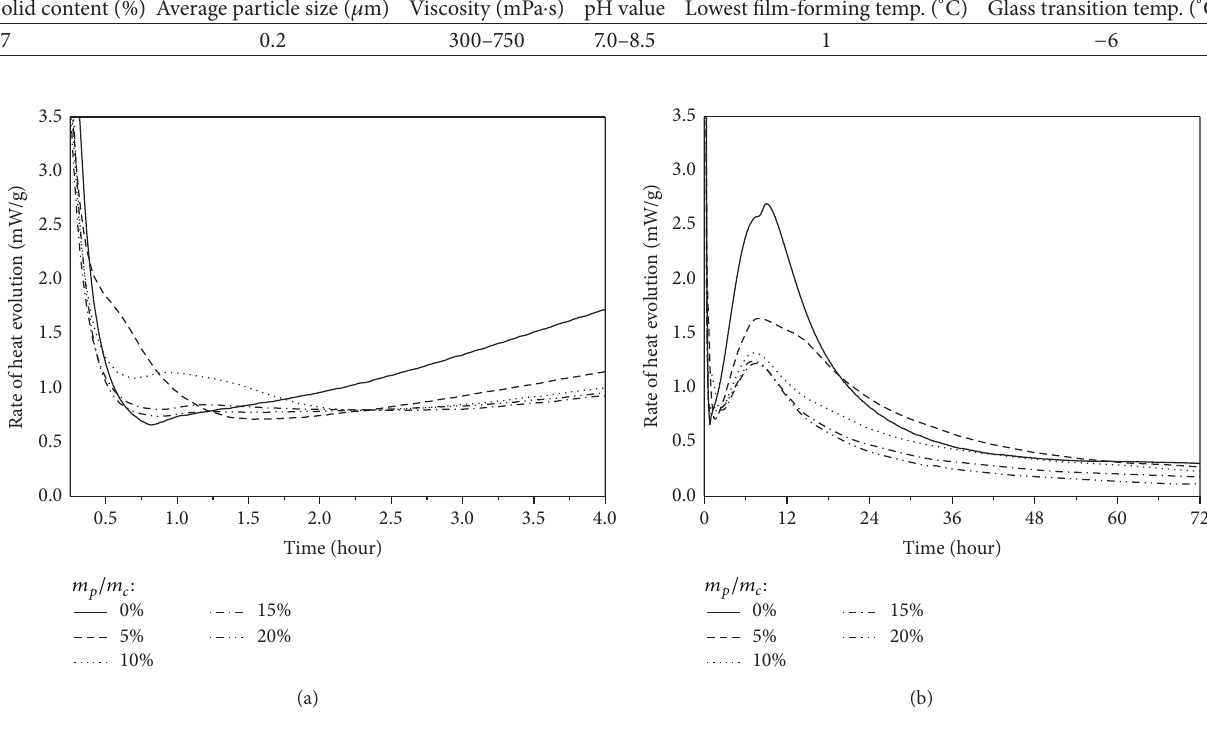
Figure 1: Rate of heat evolution of cement hydration in different 𝑚 𝑝 /𝑚 𝑐